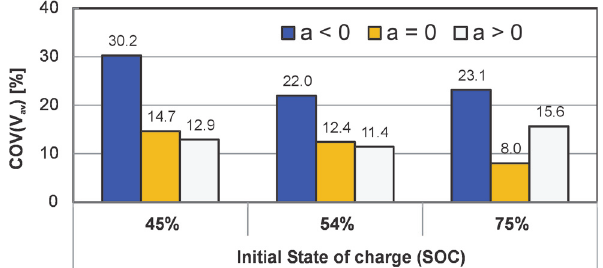
Fig. 12. The mean values of vehicle speeds distribution with division into a braking phase, constant speed phase and acceleration